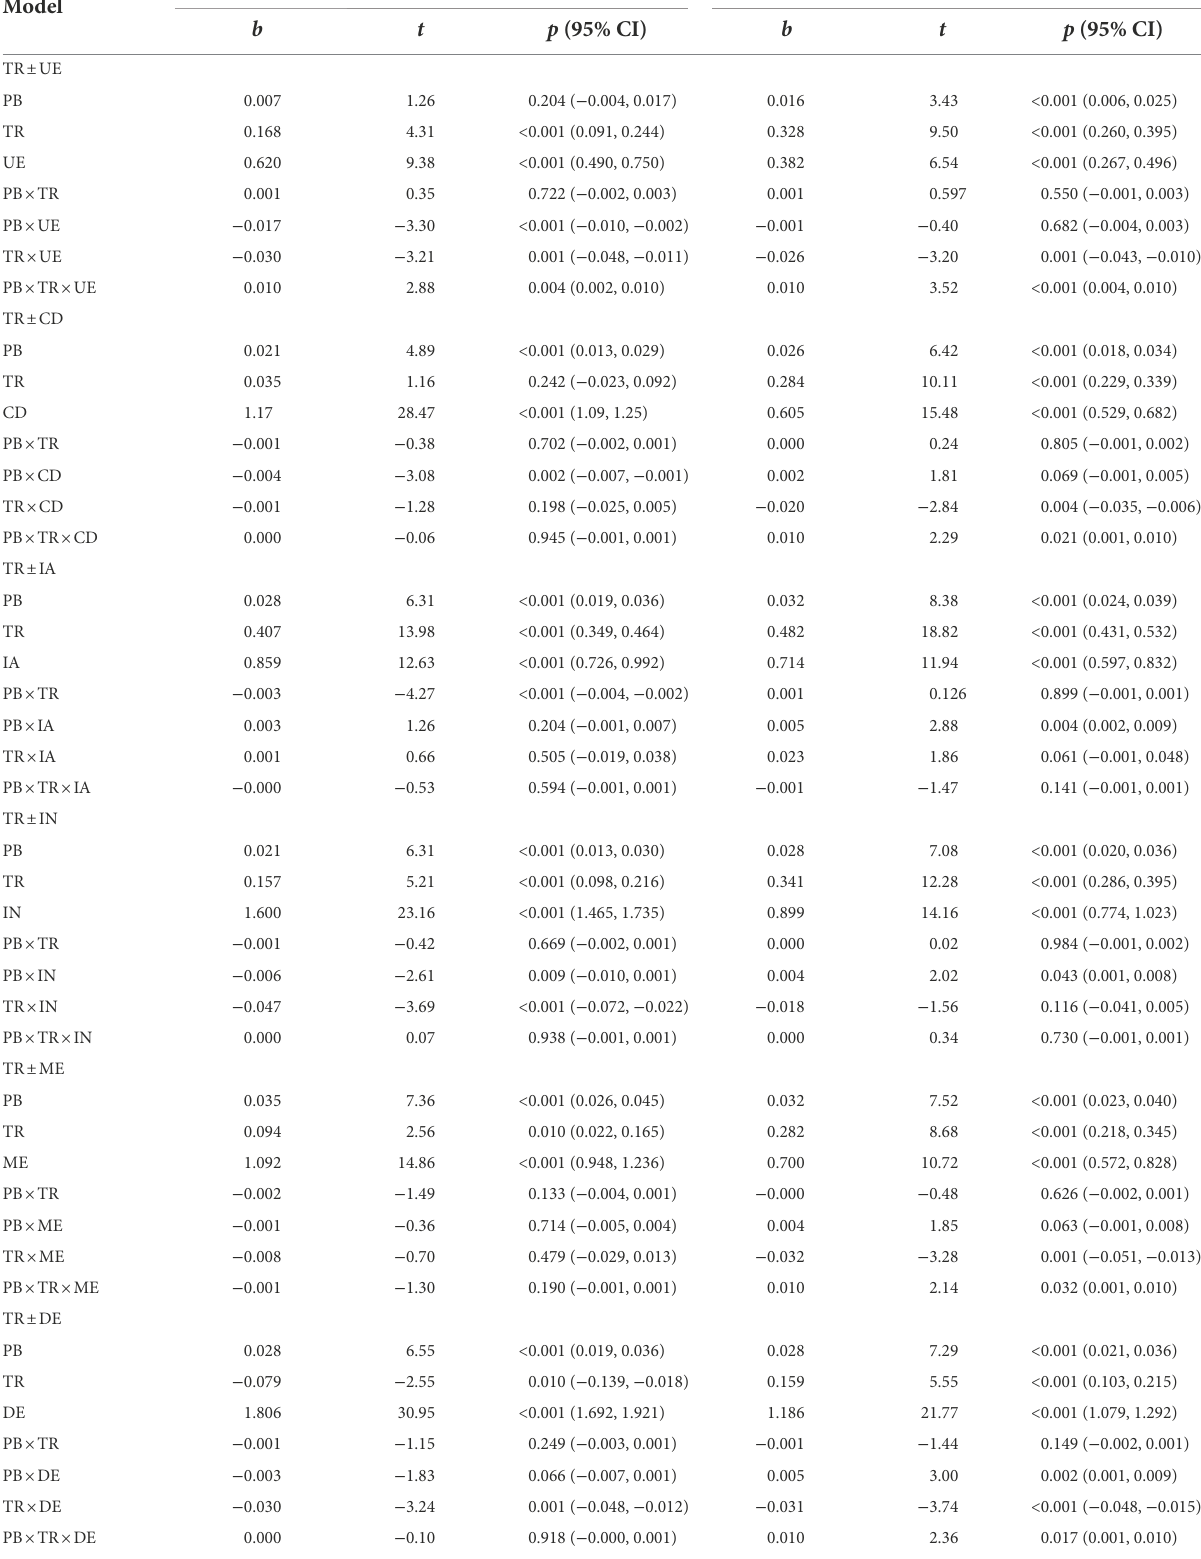
TABLE 2 Transliminality and psychopathology-related variables as potential predictors/moderators of Perceived Stress and Somatic Complaints. Perceived Stress Somatic Model